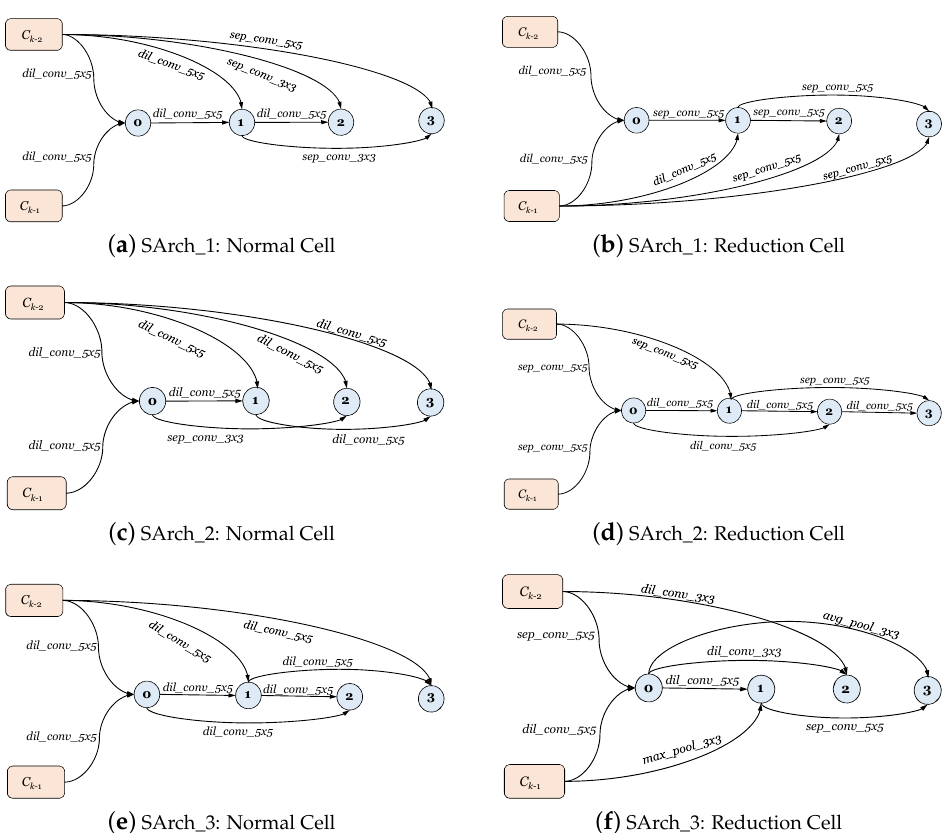
Figure A2. Cell structures of SArch_1, SArch_2 and